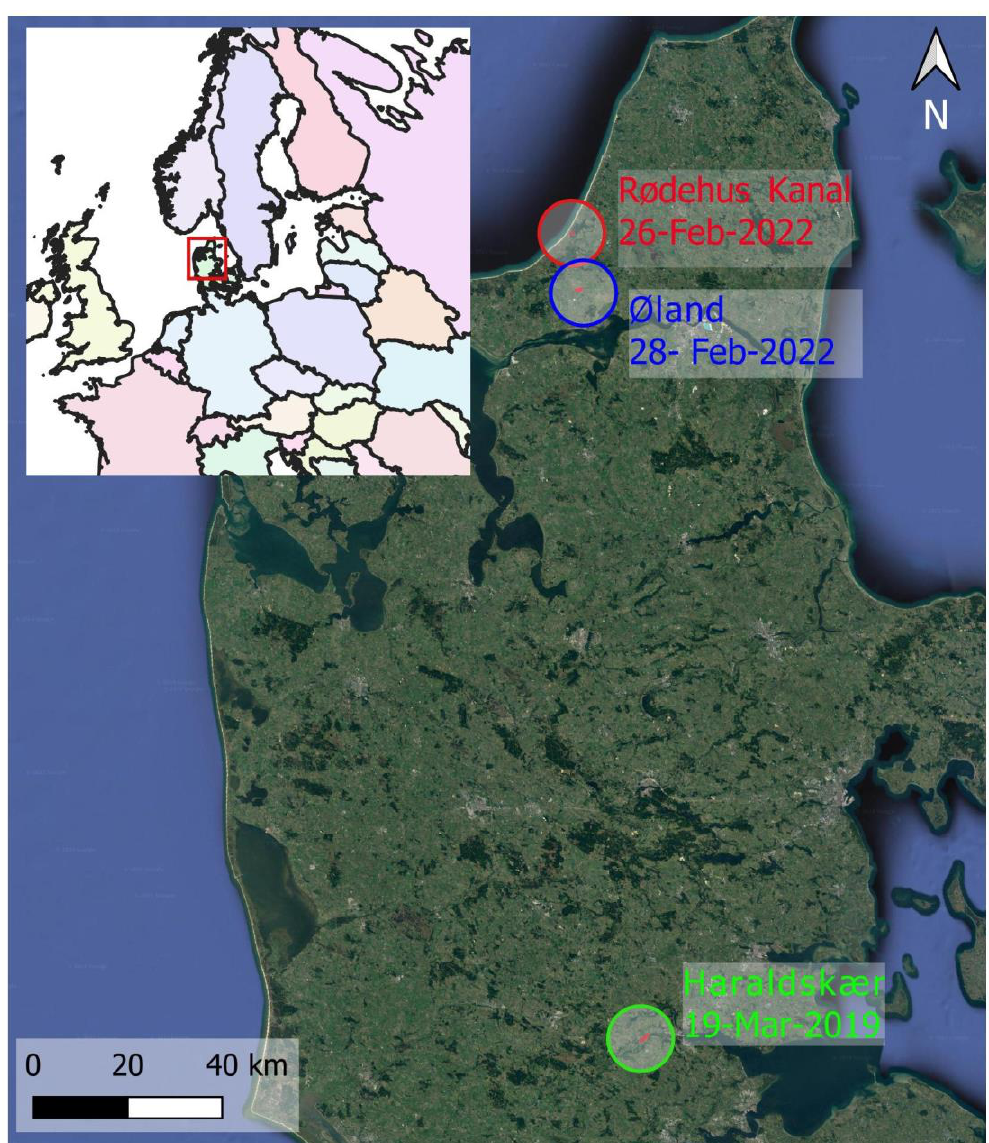
Figure 1. Overview of thermal survey sites and dates. Inset map shows the location of the study sites in Europe: Rødehus Kanal (approx. Lat: 57.226, Lon: 9.558), Øland (approx. Lat: 57.118, Lon: 9.554) and Haraldskær (approx. Lat: 55.695, Lon: 9.425). All processed flood maps are provided as geotiff raster files in the Supplementary Materials of this paper.